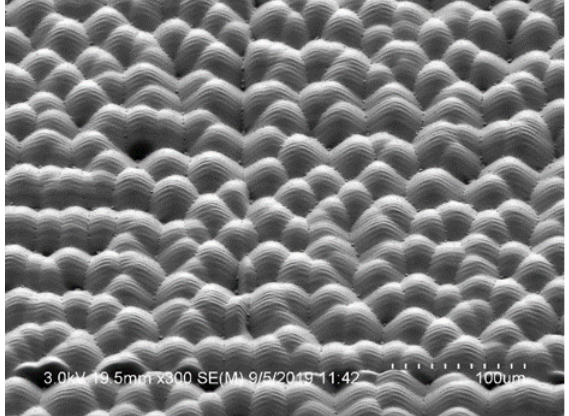
Figure 2. The convex share structure was developed for the microstructure of the diffuser on the top of a lens.